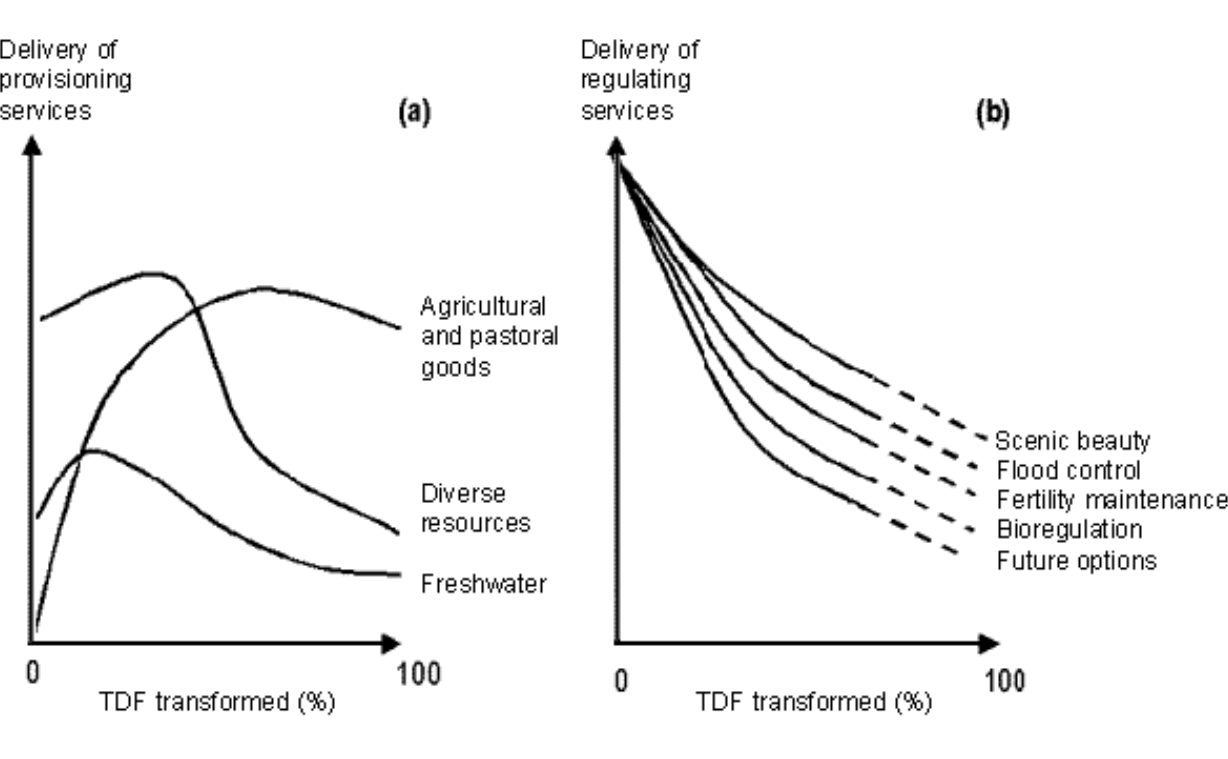
Fig. 6. Trade-offs among services delivered by a tropical dry forest region of western Mexico represented by the relationship between the intensity/amount of delivery and percentage of TDF transformed: (a) provisioning services, (b) regulating